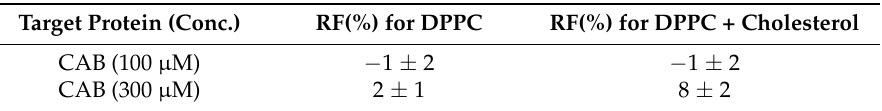
Table 1. Averaged RF’s of liposome suspension of DPPC and DPPC/Cholesterol added with 100 μM and 300 μM CAB after 60 min from the start.